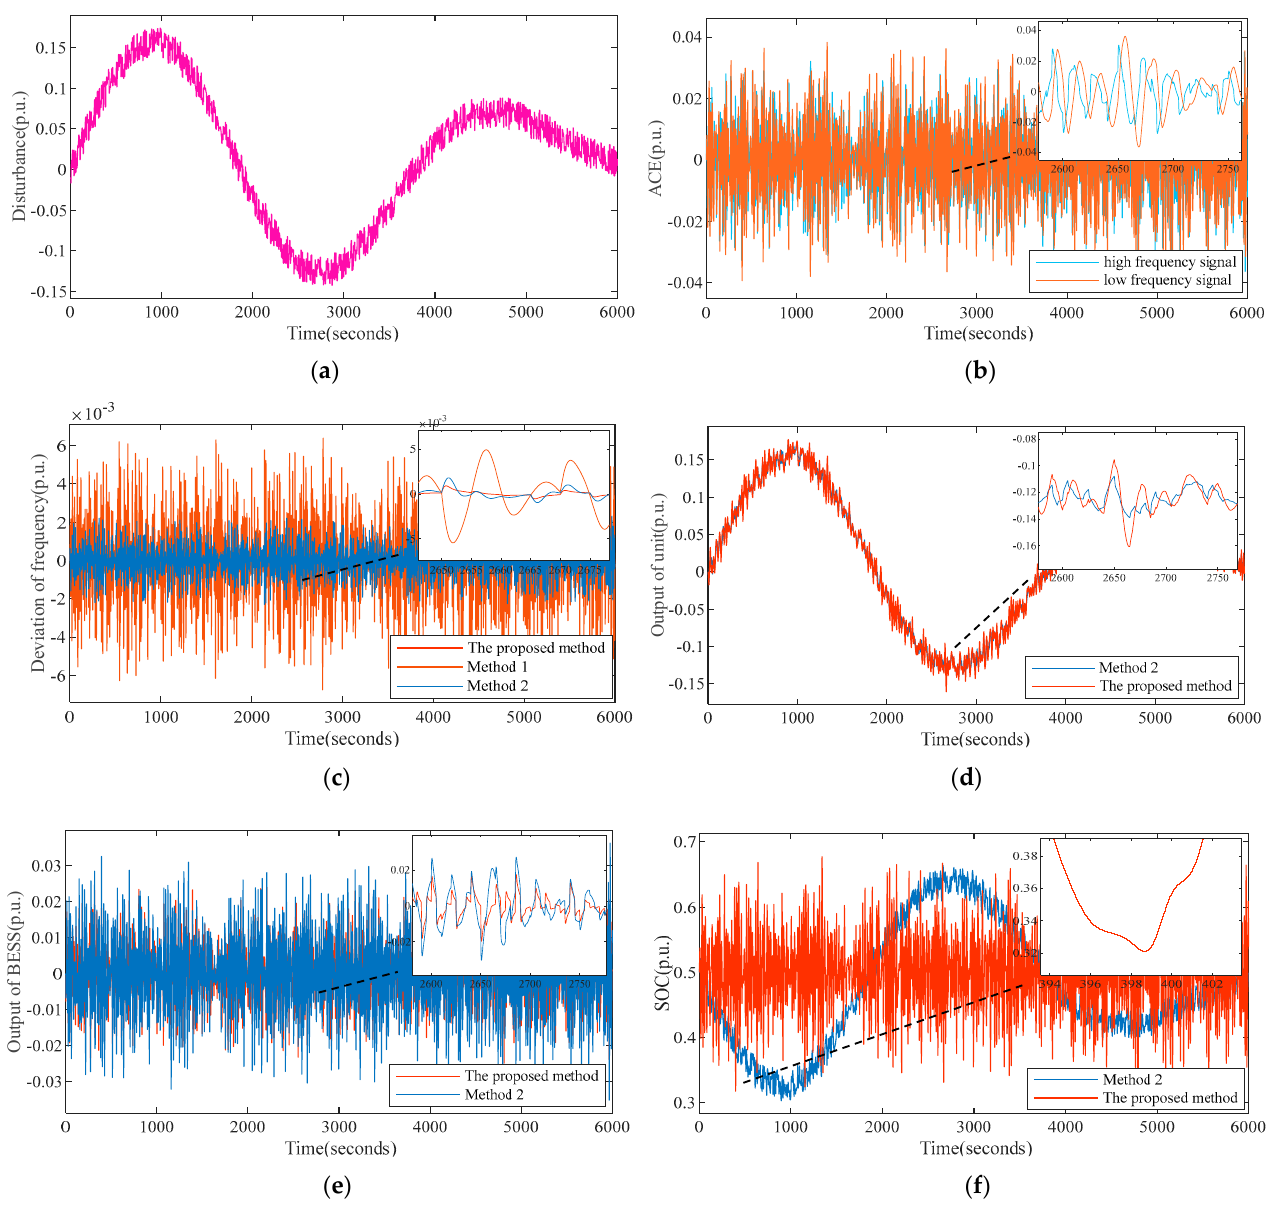
Figure 8. System response applying with continuous perturbation applied. ( a ) Continuous loading disturbance. ( b ) Low frequency signal and high frequency signal. ( c ) Deviation of frequency. ( d ) Output of unit. ( e ) Output of BESS. ( f ) The change of SOC. Table 4. Frequency regulation evaluation index under continuous